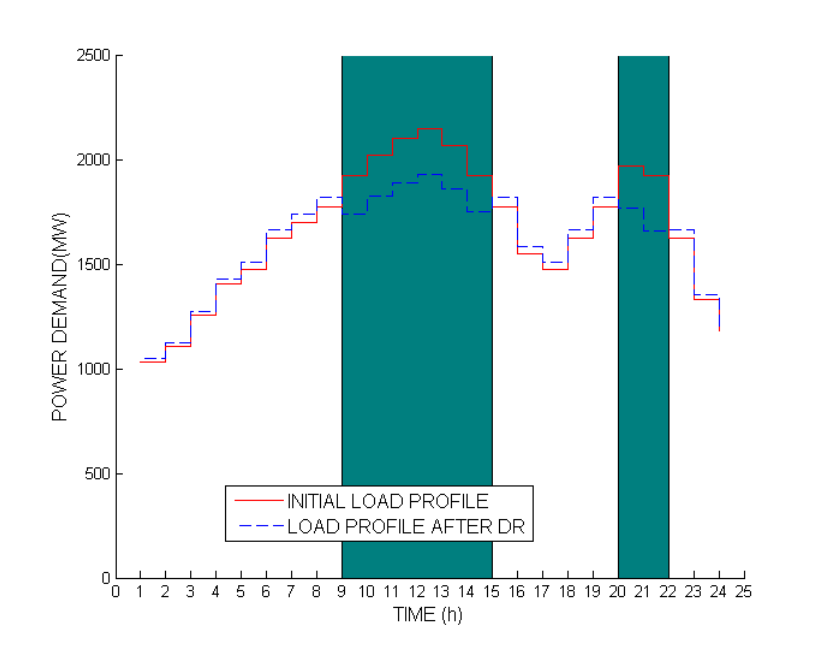
Figure 8. Initial load profile and final load profile after DR for Case 2.